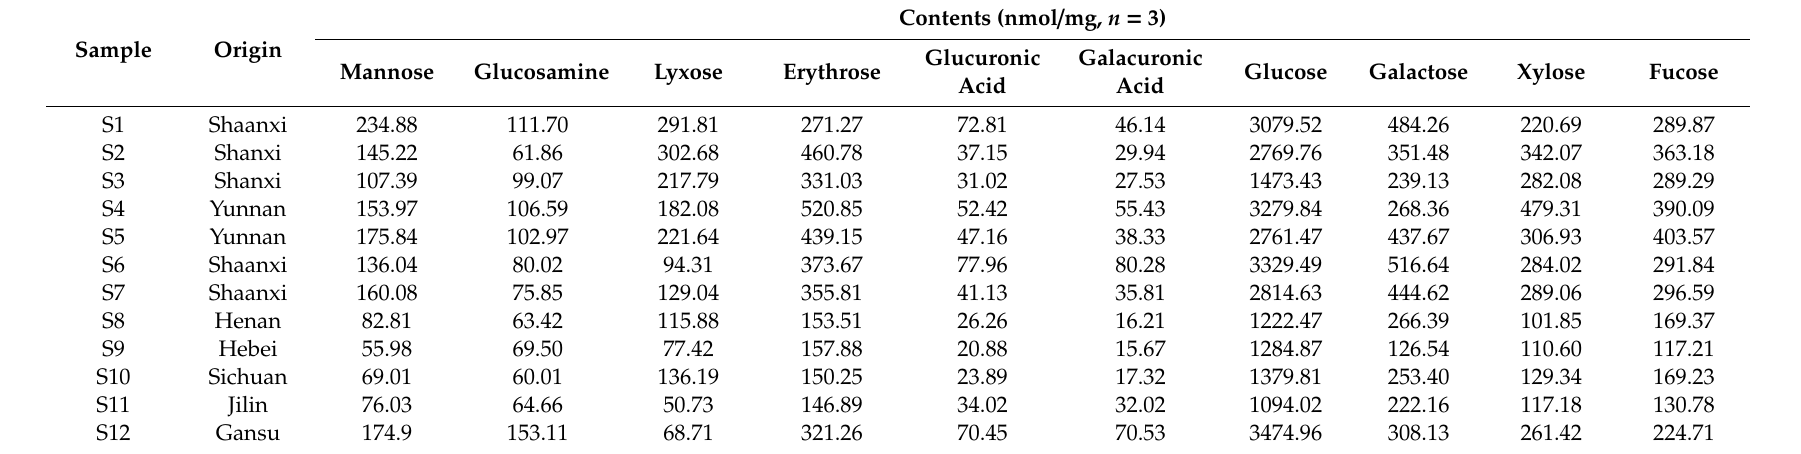
Table 5. Determination results of the monosaccharides in PPS from 12 samples of Polyporus umbellatus